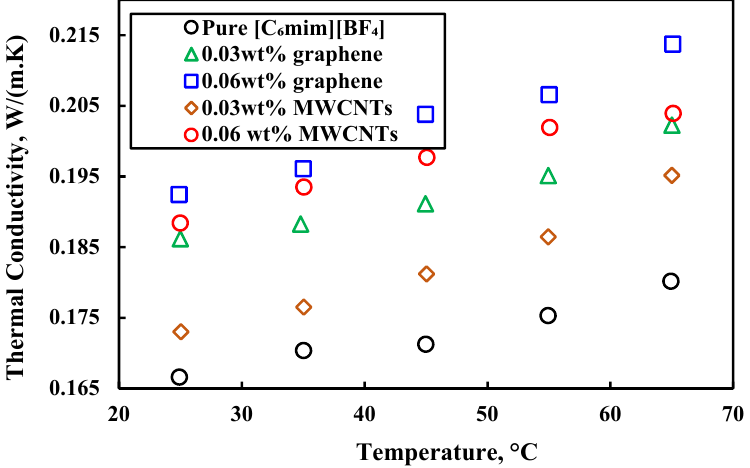
Figure Figure 11. Effect of Graphene and MWCNT concentration on the thermal conductivity of [C 6 mim][BF 4 ] IL [53]. Reproduced with permission from F Wang, Nanoscale research letters; published by [Springer], 2012 .